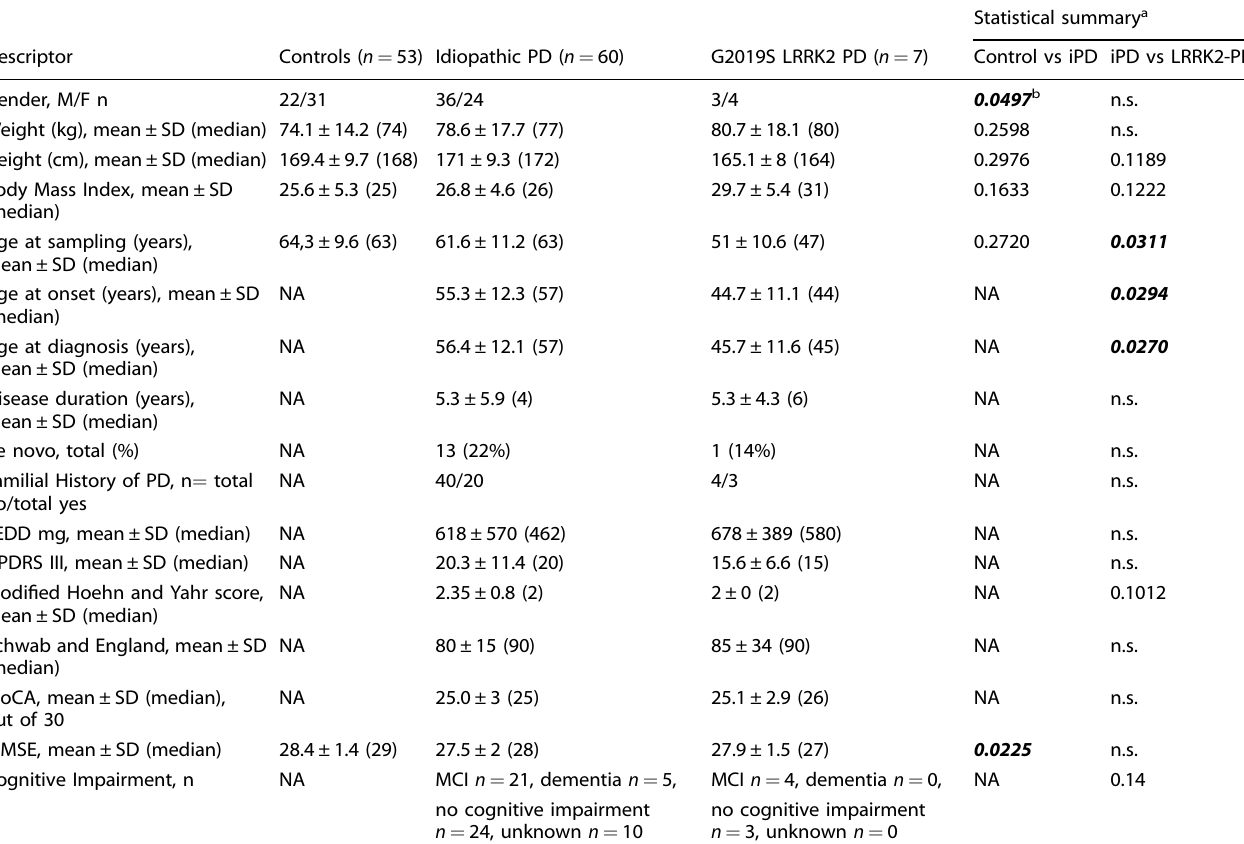
Table 2. Overview of clinical parameters from clinical cohort 2 (cohort from Lille University